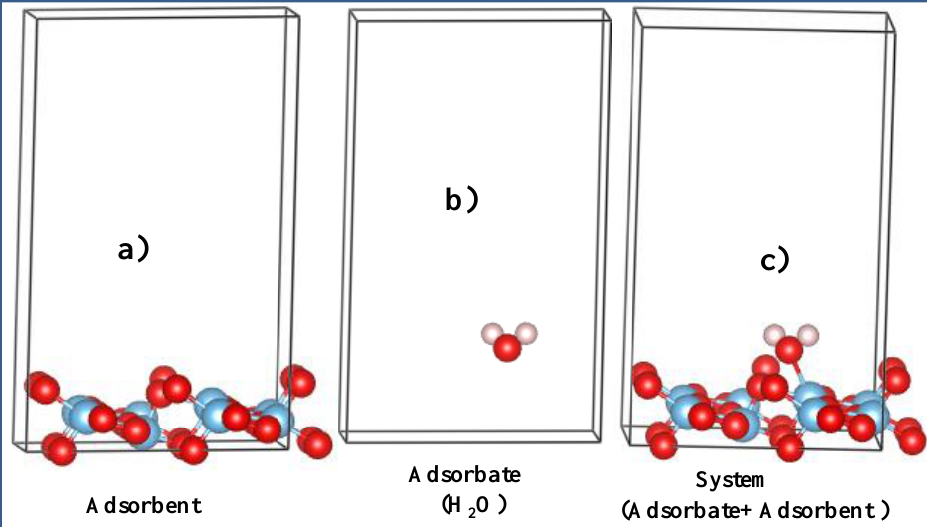
Figure 1. Structural images of the titanium dioxide cell, water molecules and water on the titanium dioxide surface. Titanium atoms are blue, oxygen atoms are red, and hydrogen atoms are